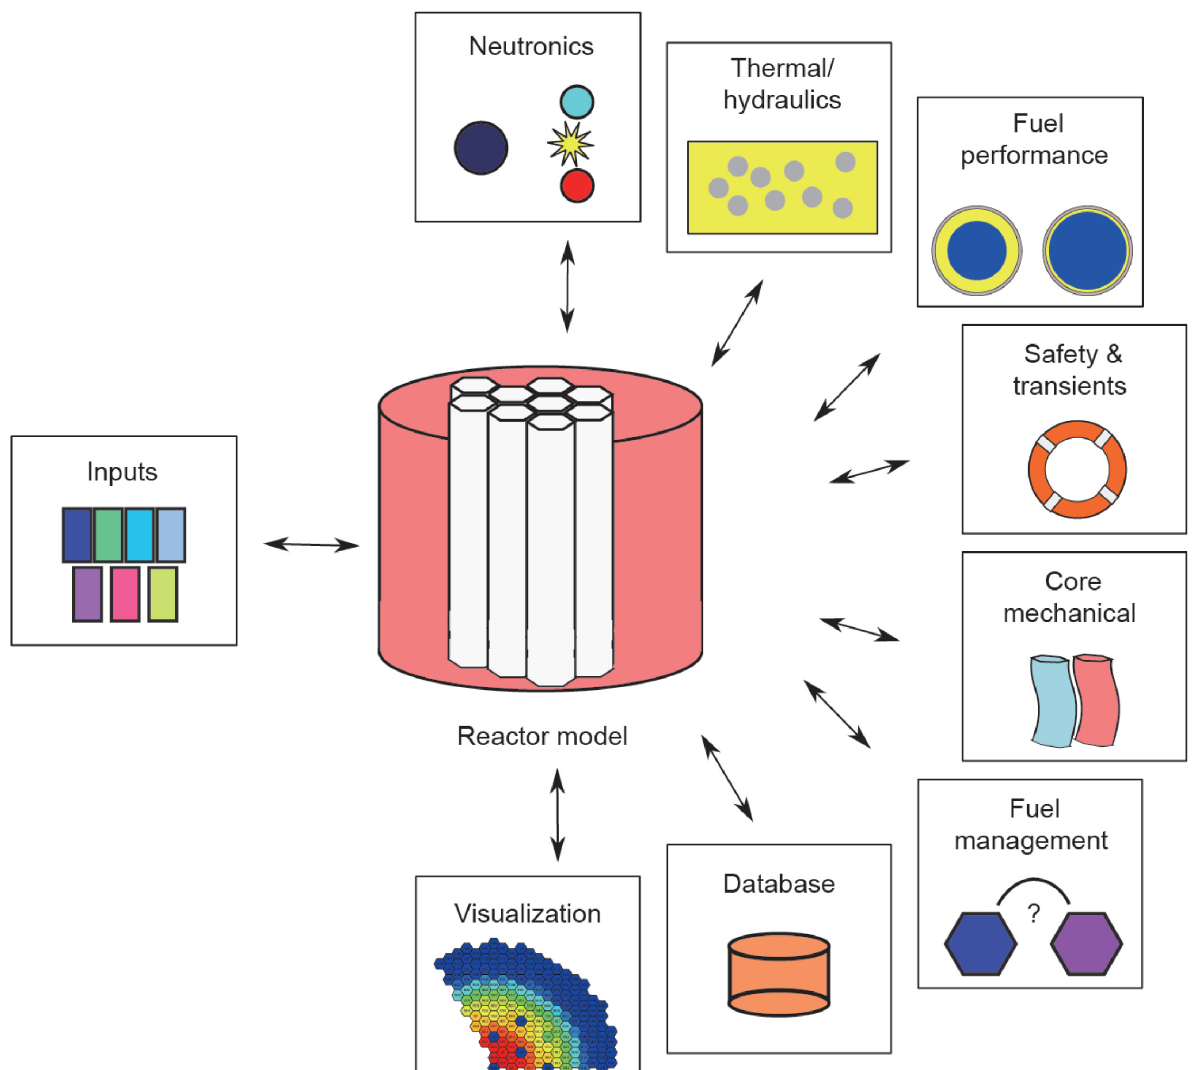
Figure 6. A depiction of the interface stack operating on the reactor model. Each arrow can be implemented with FMI where each box represents a different software tool. (Source: Touran et al.